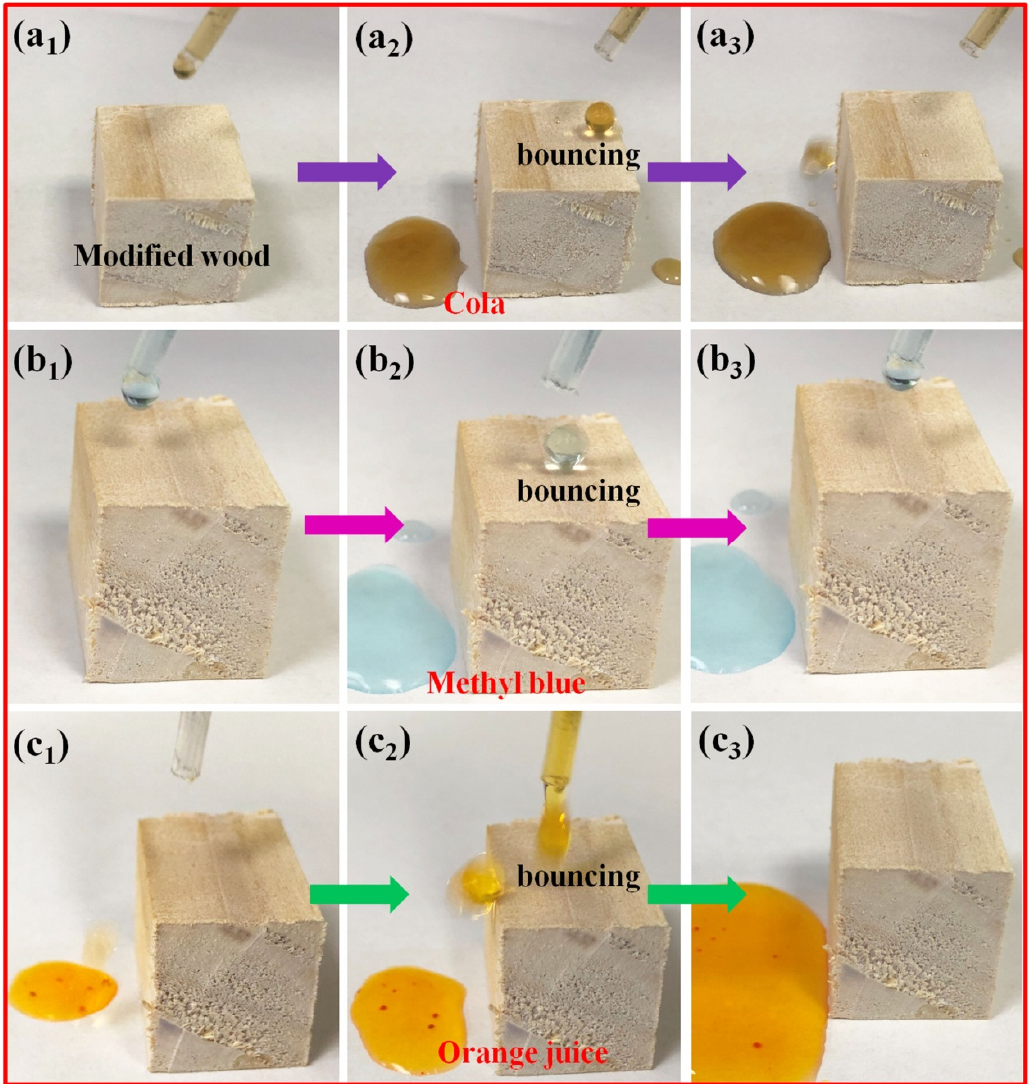
Figure 8. Anti-fouling performance test of superhydrophobic silicone resin coating on treated wood surface: ( a 1 – a 3 ) Wetting resistance test of superhydrophobic wood to cola; ( b 1 – b 3 ) Wetting resistance test of superhydrophobic wood to methyl blue; ( c 1 – c 3 ) Wetting resistance test of superhydrophobic wood to orange juice.